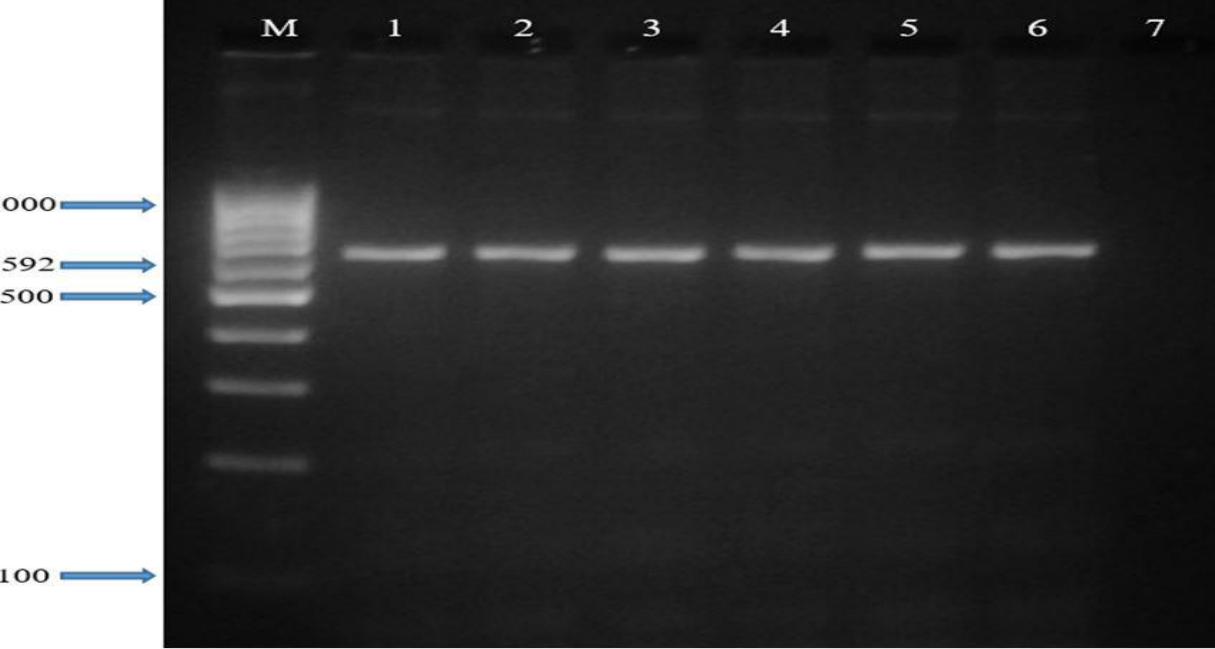
Fig.3: Stx2 gene product in E. coli 157:H7 isolates (592